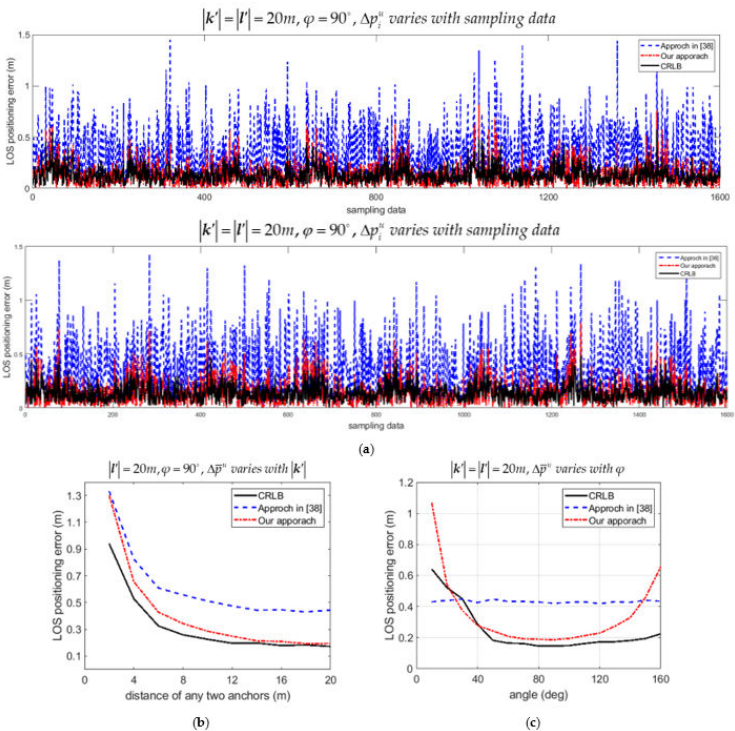
Figure 7. Comparison of upper bound of 2D positioning errors estimated by our approach and the approach in [38] for the LOS condition. ( a ) Variation of ∆ p u (cid:12) (cid:12) distance (cid:12) k (cid:48) (cid:12) ; ( c ) Variation of ∆ p u with angle ϕ .